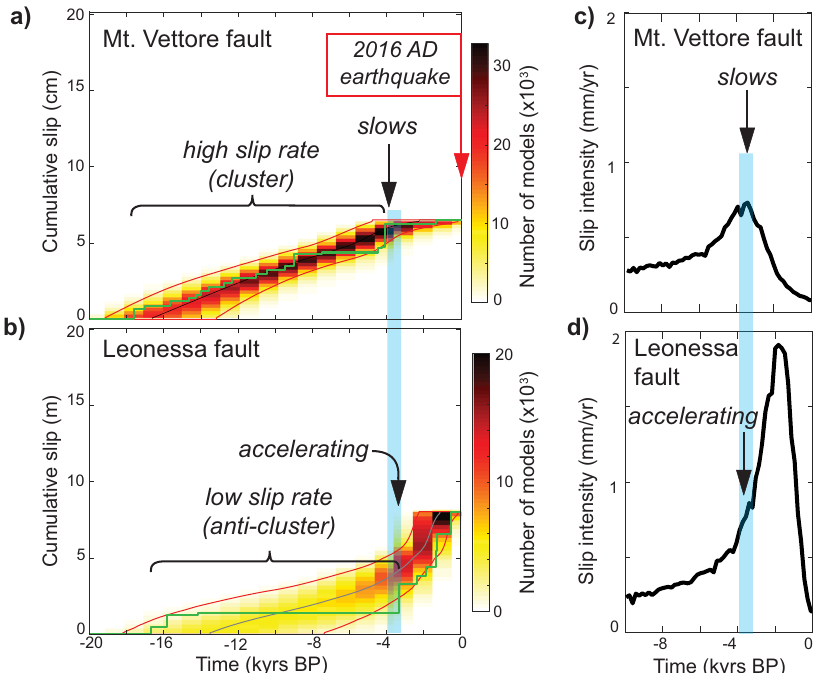
Fig. 4 | Slip histories for the Mt. Vettore and Leonessa faults that are located across strike from each other. a , b show the best least squares slip histories with stepped green lines, and the color scale indicates the top 100,000 (after model burn-in) least squares slip histories for each fault. These represent the best fi ts to the data without penalization of results by priors used in the modeling during the operation of the Markov chains. We also show the 90% con fi dence bounds (red lines)derivedfromtheposteriordistributionsproducedbytheBayesianmodeling. c , d show the mean slip intensity results for the same model runs as a and b , but